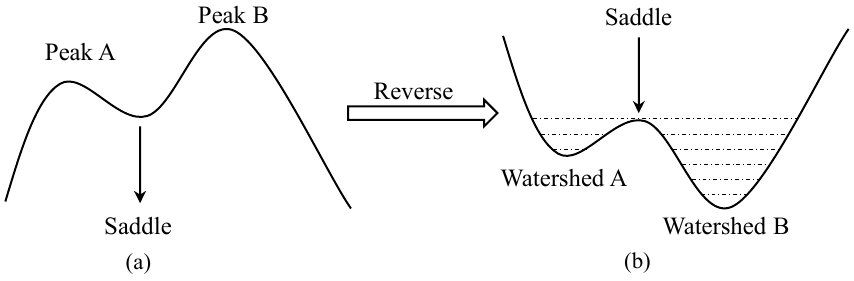
Figure 5. Correspondence between peaks and saddles in original and anti-terrain: ( a ) the peaks and saddles in the original terrain; ( b ) the peaks and saddles in the corresponding anti-terrain. Feature-point cluster extraction and verification . The feature-point clusters include peaks, saddles, and runoff nodes, among which peaks are obtained by the space segmenta- tion method described above. The saddles and runoff nodes are obtained by intersecting the ridgelines with the peak control areas’ boundary and self-intersecting the peak con- trol areas, respectively. The point cluster verification is realized by positive and negative terrain filtering. According to the geomorphological viewpoint, the peaks and saddles are the convex points of the local terrain, which should be located in the positive terrain. Correspondingly, the runoff nodes should be located in the negative terrain. Therefore, the pseudo peaks and saddles can be eliminated by positive terrain checking, and pseudo runoff nodes can be eliminated by negative terrain checking. Finally, the integrated terrain feature-point clusters are